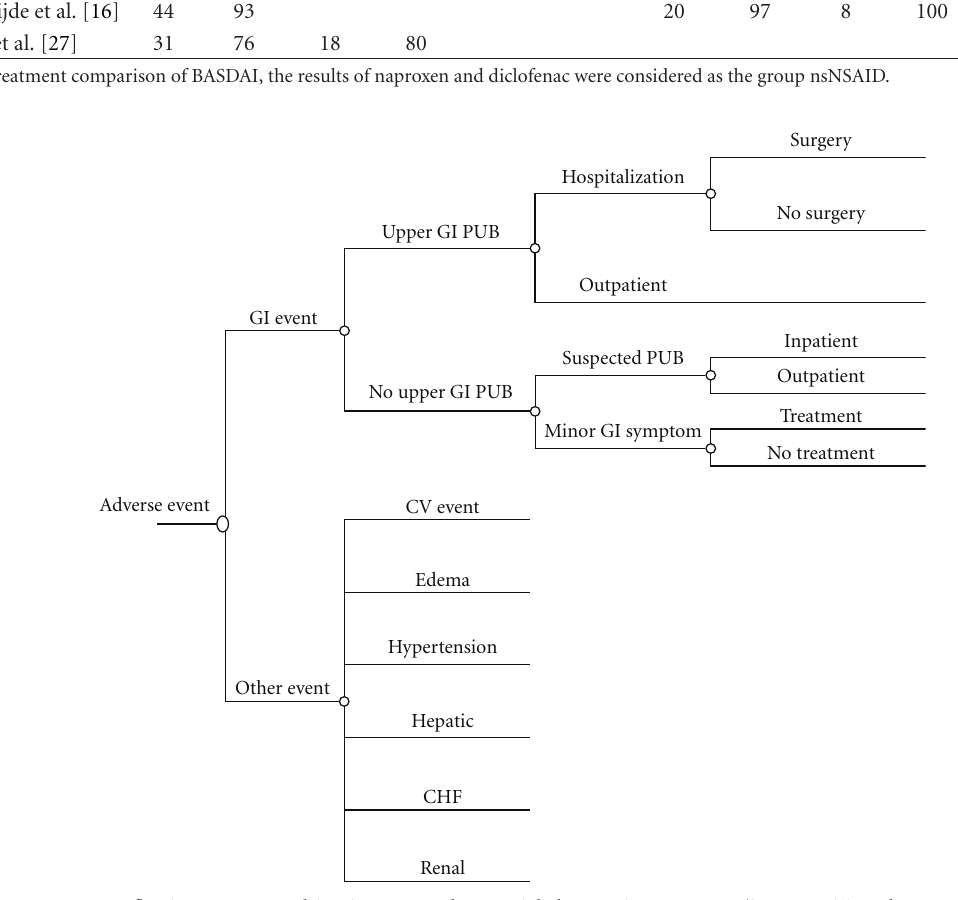
Figure 1: Tree structure reflecting events resulting in costs and potential changes in treatment (i.e., transitions between health states of the Markov